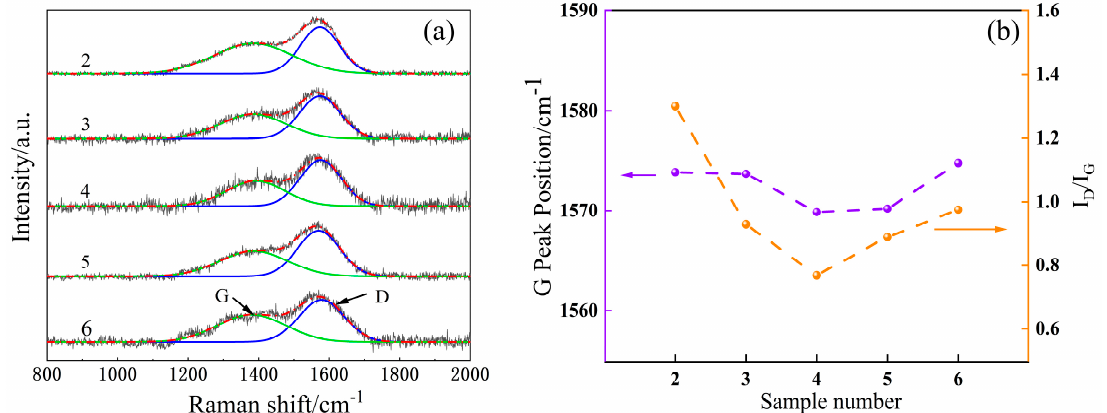
Figure 3. Raman spectra, I D /I G , and G peak positions of the Si-B-C-N/DLC gradient films. ( a ) Raman spectra of Samples 2 – 6, ( b ) Variations in the I D /I G and G – peak positions of Samples 2 – 6.